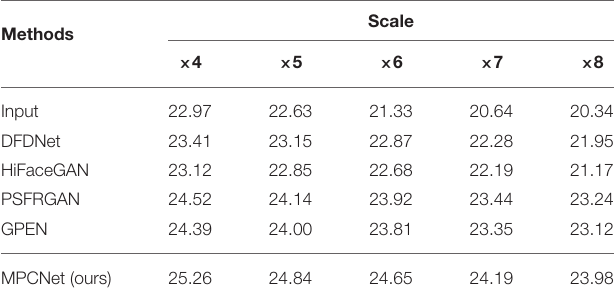
TABLE 4 | Peak signal-to-noise ratio (PSNR) results achieved for 4 / 5 / 6 / 7 / 8 face super-resolution × × × × ×